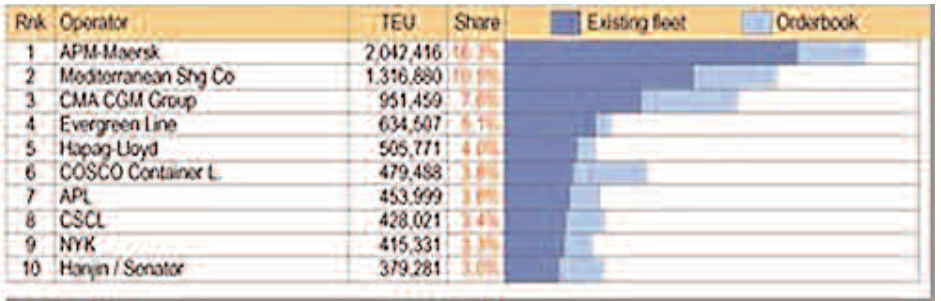
Table 2. Top Ten Container Operators AXS-Alphaliner TOP 100